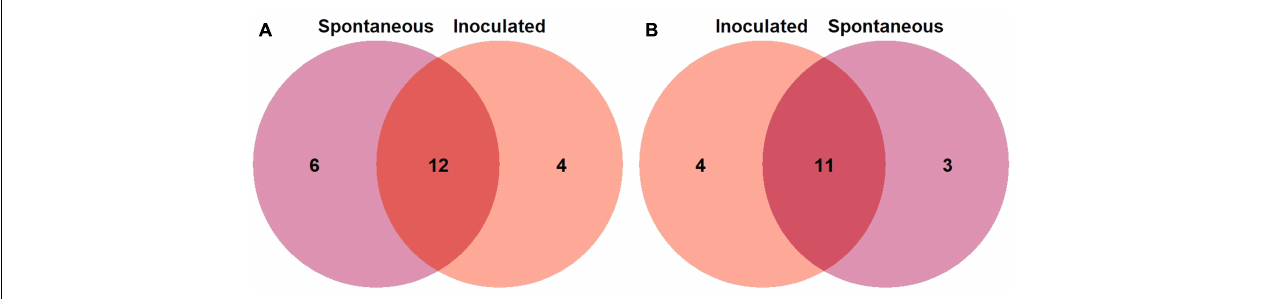
FIGURE 5 | Venn diagrams of the number of unique and shared amplicon sequence variants (ASVs) of the (A) bacterial and (B) fungal community associated with the fermentation practices of colonche samples inoculated (red) and spontaneous (purple).